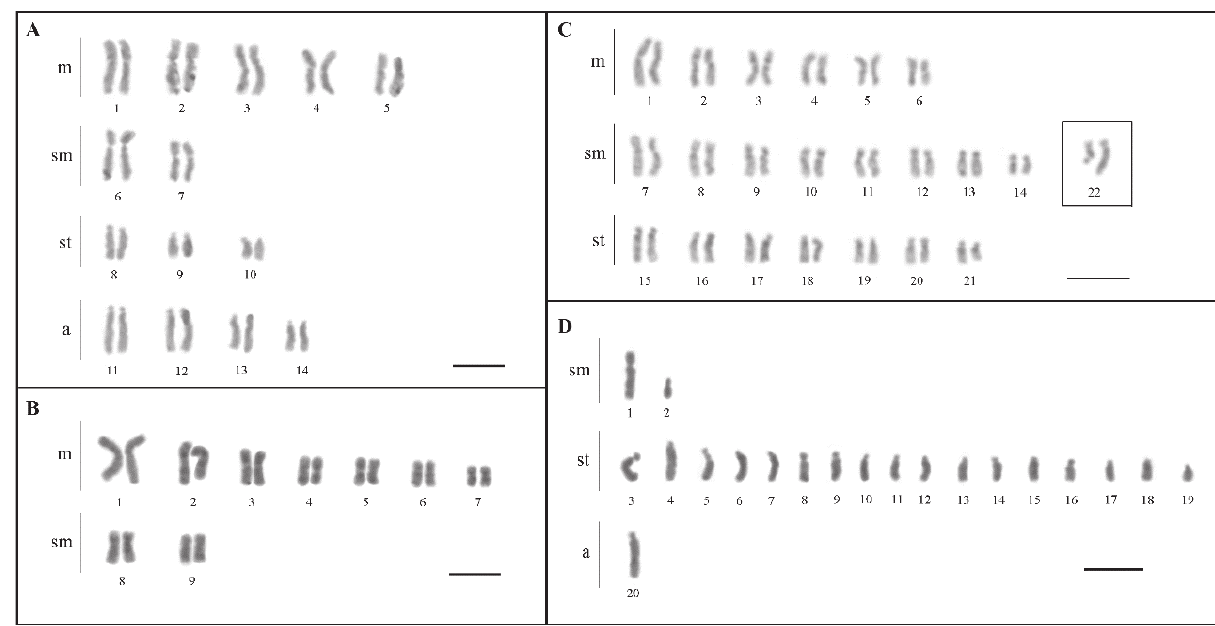
Figure 1. Karyotypes of ant species from subfamilies: Dolichoderinae - (A) Azteca sp. group chartifex (2n = 28), (B) Dolichoderus bidens (2n = 18); Ectatomminae - (C) Gnamptogenys tortuolosa (2n = 44); and Formicinae - (D) Camponotus renggeri (n = 20). Box in (C) show size heteromophism of the long arm of pair 22 in G. tortuolosa , with one homologous submetacentric and the other subtelocentric chromosome. Scale bars = 5